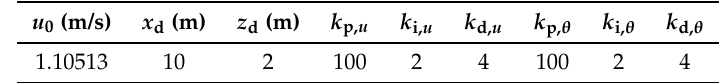
Table 1. Parameters used by the PID controller.